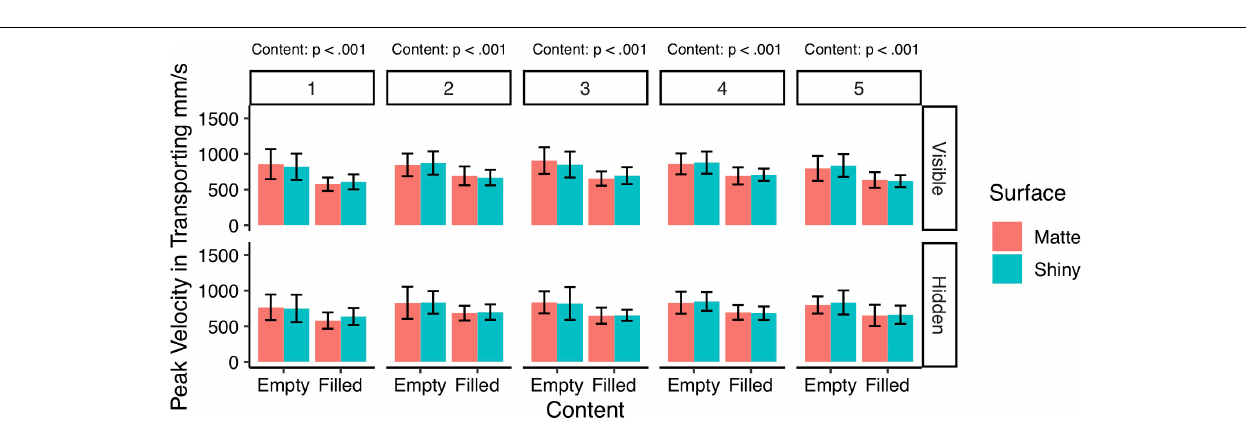
FIGURE 6 | Grip deviations from the center of mass (COM) in mm as a function of manipulated properties, for the first block of trials (left) , and across all blocks of trials (right) . The COM is measured from the base of the cups and is positioned at 65 mm for empty cups, and 46 mm for filled cups and is represented respectively as a zero on the y-scale. The error bars are standard errors. Significant difference was found between empty and filled cups. Surface is shown for comparison purposes.